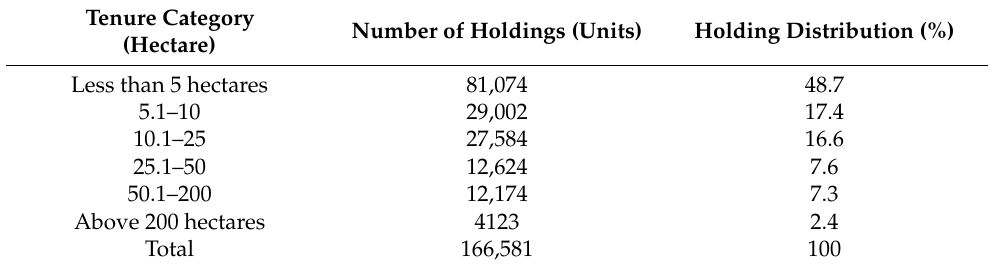
Above 200 hectares